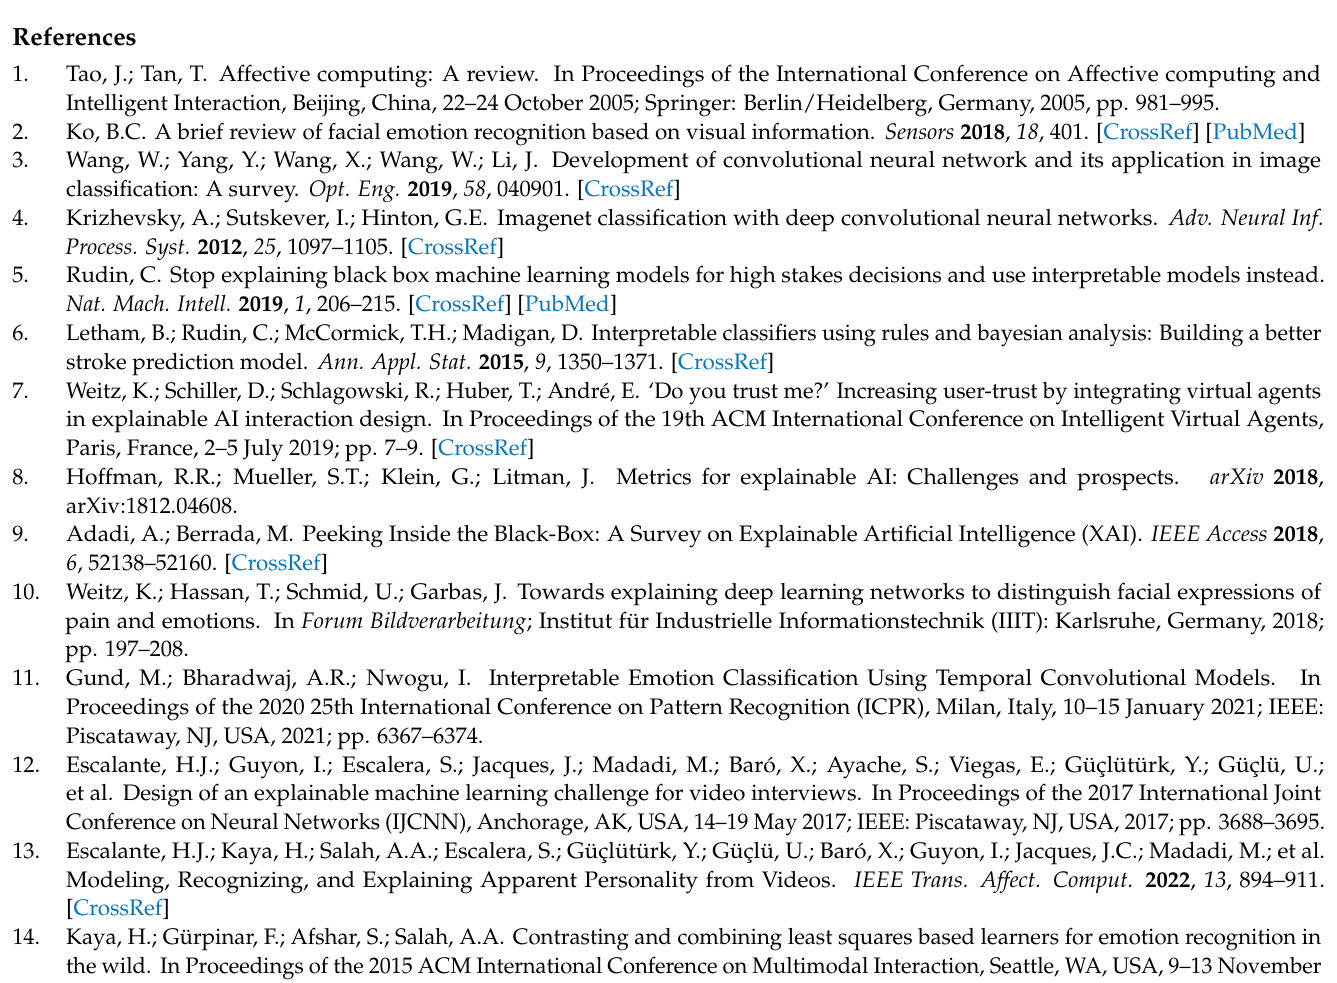
Figure A1. All landmarks with their corresponding numbers annotated. The numbers correspond to the numbers in Table A2. Example image is AF01AFS from the KDEF